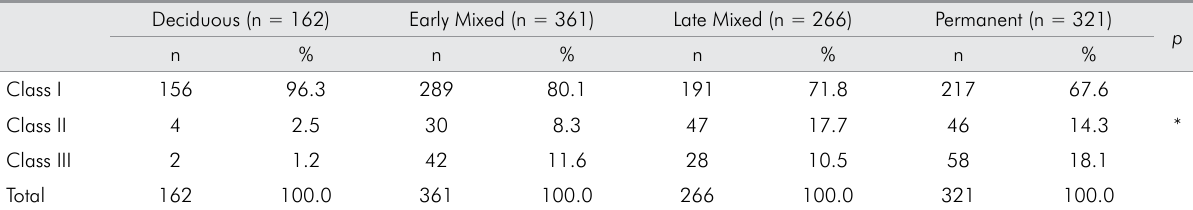
Table 2. Distribution of sagittal occlusal relationships in subjects in each dentition stage. Deciduous (n =